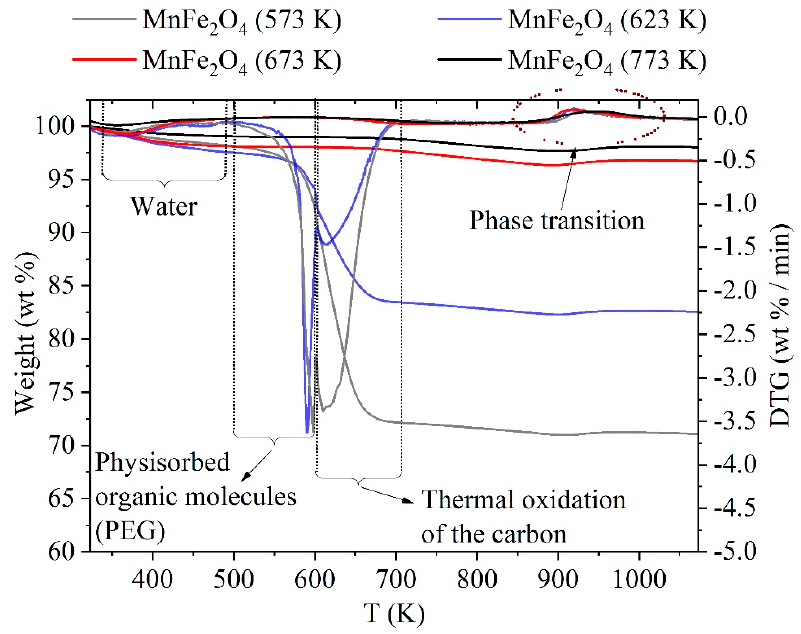
Figure 4. TG and DTG curves of the ferrite samples in air atmosphere.